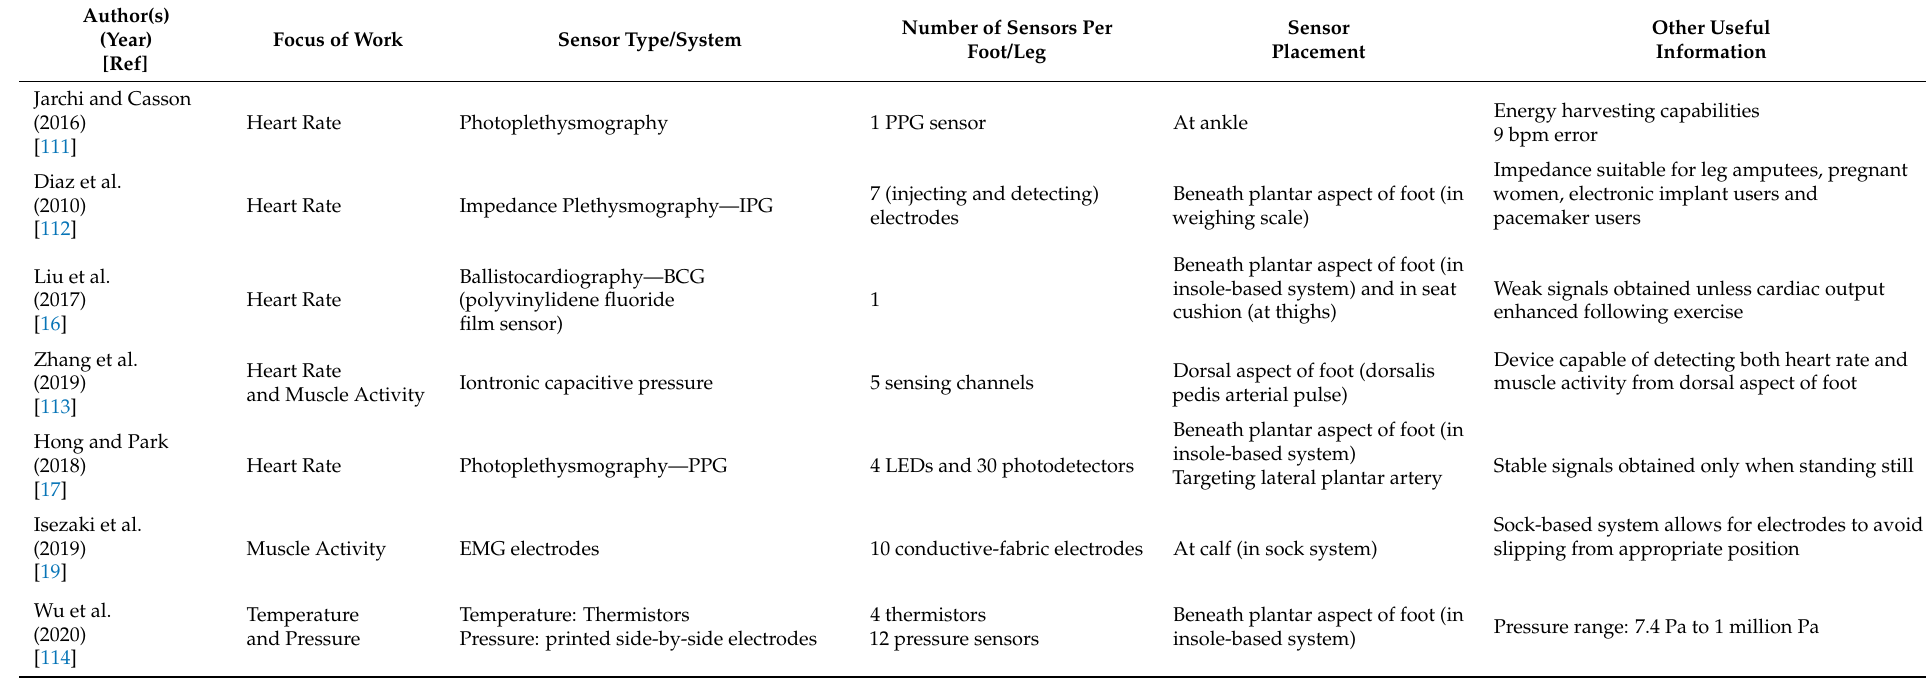
Table 4. Key points pertaining to various existing sensor systems measuring physiological parameters at or near the